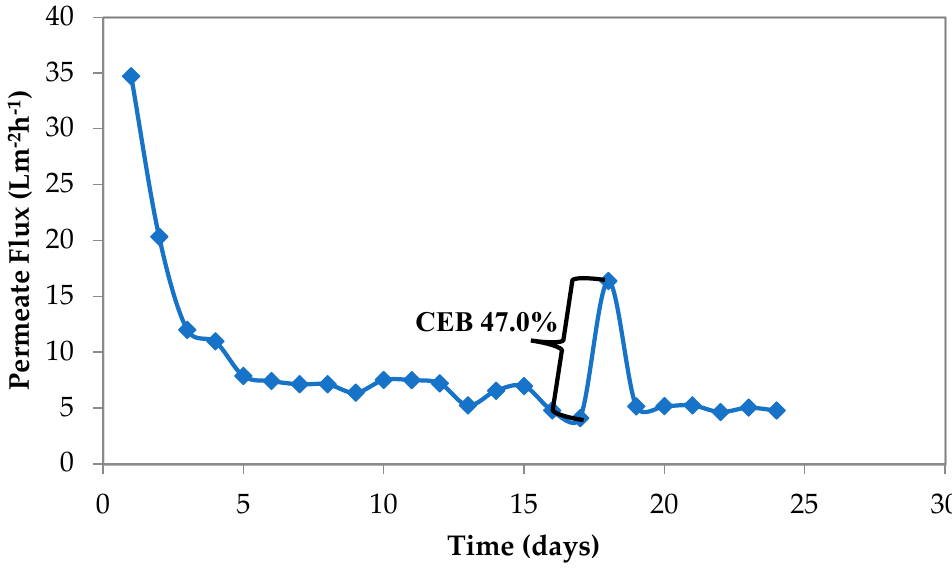
Figure 6. Temperature corrected flux versus time plot when an air diffuser with 1 mm of perforated hole diameter was used.